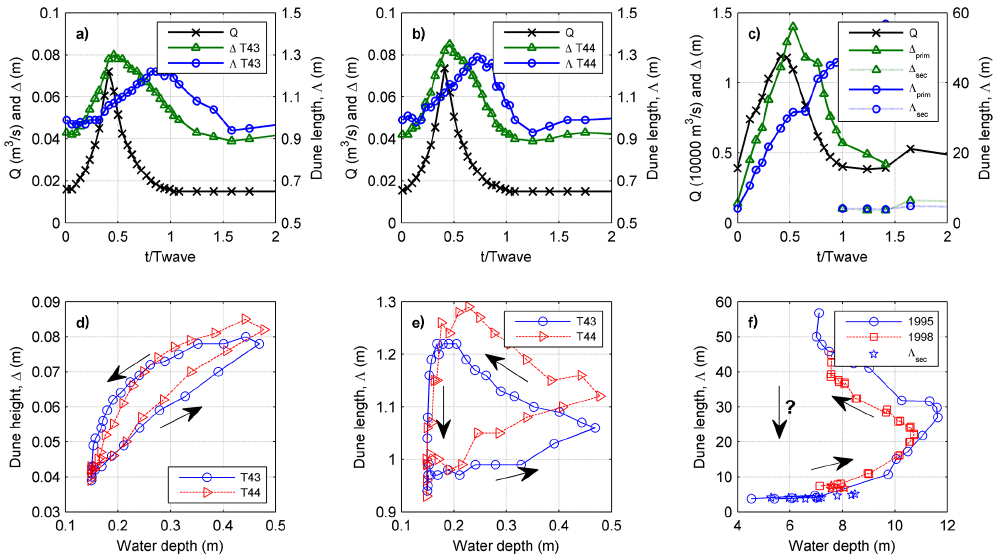
Figure 3. Averaged dune heights and lengths in the flume ( a : T43, T wave =3.5h and (b) : T44, T wave =7h) and the field (c: 1995 flood wave, T wave =17 days). (d) and (e) show the hysteresis curves of dune length for the two flood waves (T43 and T44) in the flume and two flood waves in the field (in 1995 and 1998). The flume data are computed from the bed profiles of Wijbenga and Van Nes (1986a) and field data are from Wilbers and Ten Brinke